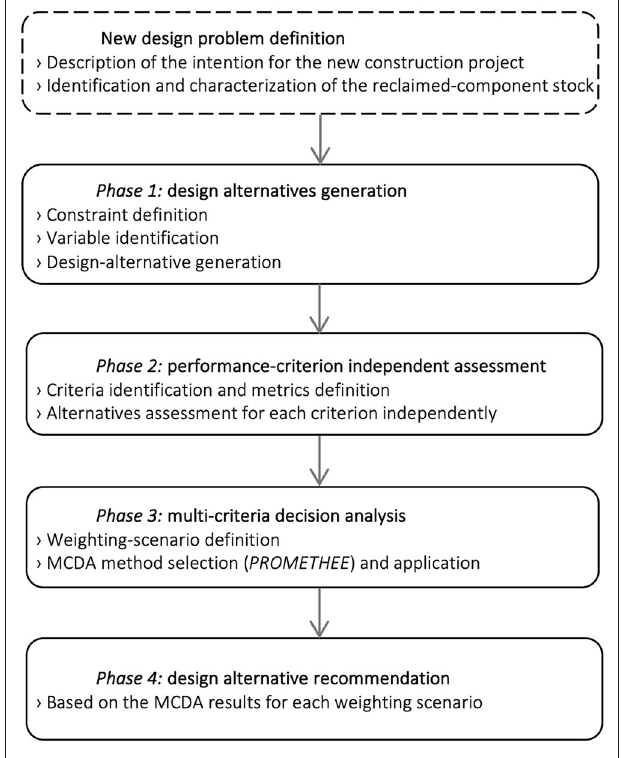
FIGURE 2 | Overview of the decision-making framework for the reuse of components in new